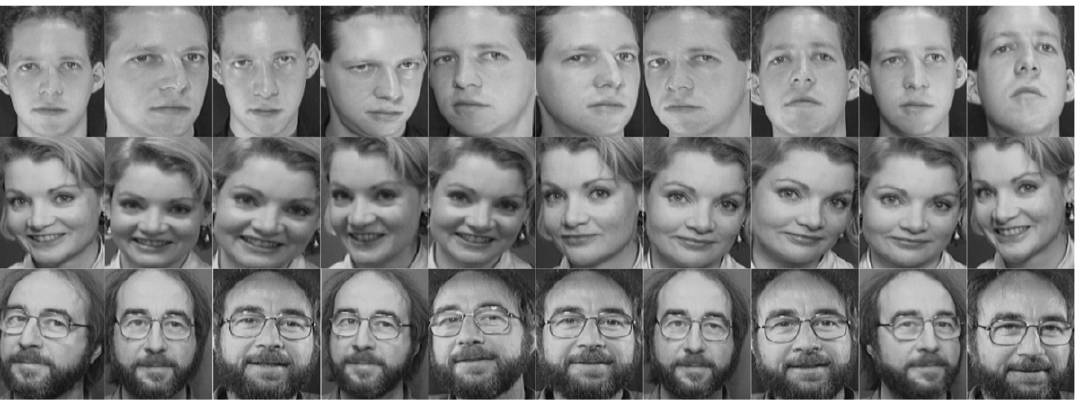
Figure 4. Example face images from the IMM Face Database.